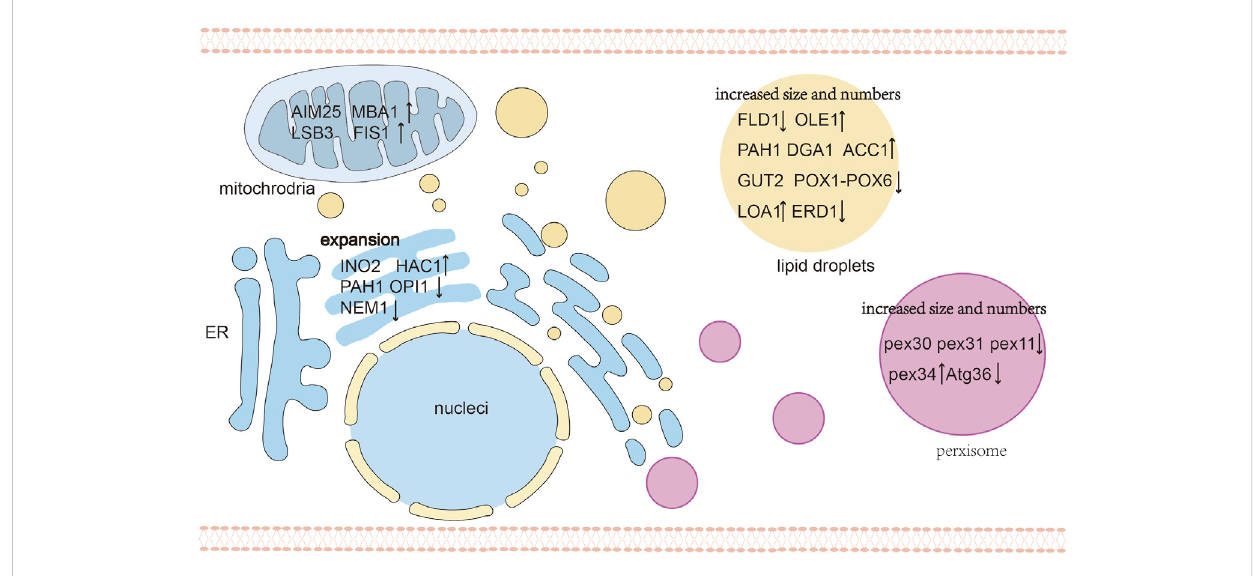
FIGURE 4 An overview of organelle morphology engineering. The target genes of different organelles are shown to regulate organelle morphology, including increased size and number of LDs and peroxisomes, expansion for ER and engineering mitochondrial physiology. Abbreviations: FLD1, seipin; OLE1, fatty acid desaturase; GUT2, G3P dehydrogenase; POX1-6, acyl-CoA oxidases 1 through 6; PEX11, PEX30, PEX32, PEX34, peroxisome-population-regulated proteins; ATG36, autophagy-relatedprotein;OPI1, negativeregulator ofphospholipid biosynthesis;NEM1,nuclear envelope morphology protein 1; HAC1, Transcriptional activator; ↑ Gene overexpression; ↓ Gene